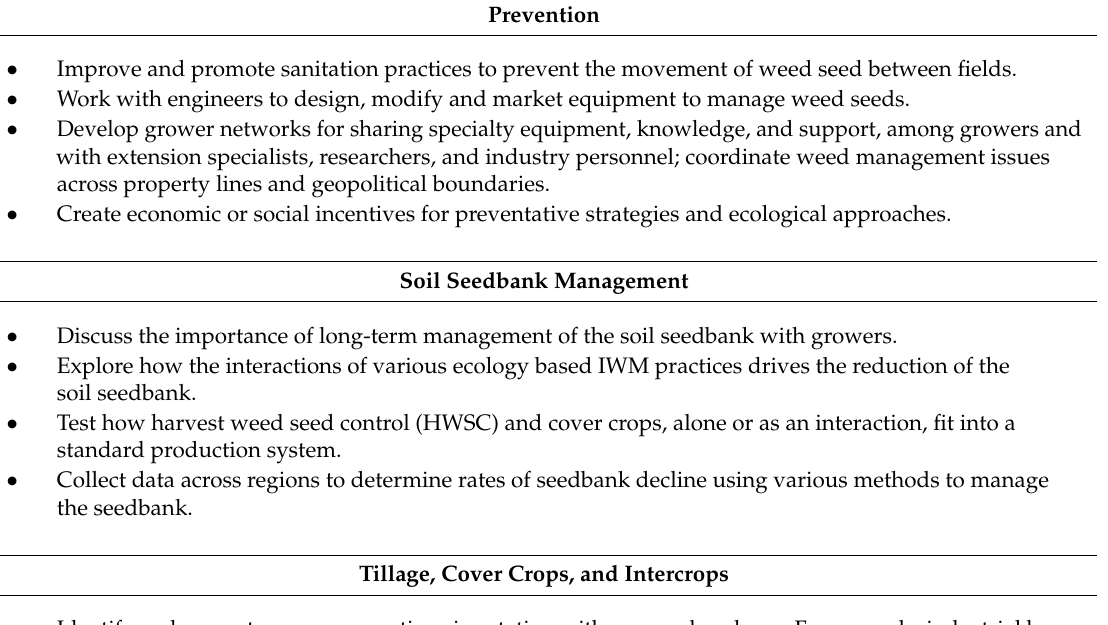
Table 1. Areas for action and additional research, and identified knowledge